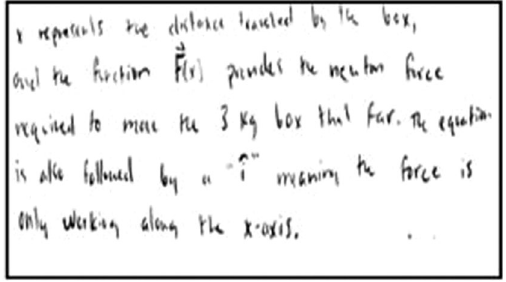
FIG. 14. Interpretation of force-position equation (question 6).